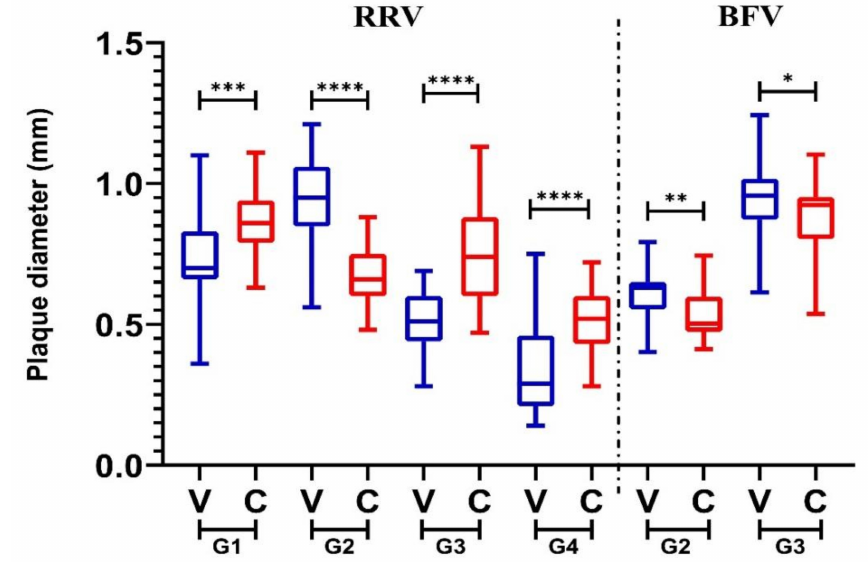
Figure 6. Size (diameter, mm) comparisons of plaques produced following inoculation of Vero cells with C6 / 36 (C, red) or Vero (V, blue) supernatant following infection with genotypes 1–4 (G1–4) of Ross River virus (left of the line) or G2–3 of Barmah Forest virus (right of the line). Plaque sizes produced in C or V cells were compared for each virus, significance values are shown above these datasets (**** p ≤ 0.0001, *** p ≤ 0.001 ** p ≤ 0.01, * p ≤ 0.05) as determined by the student